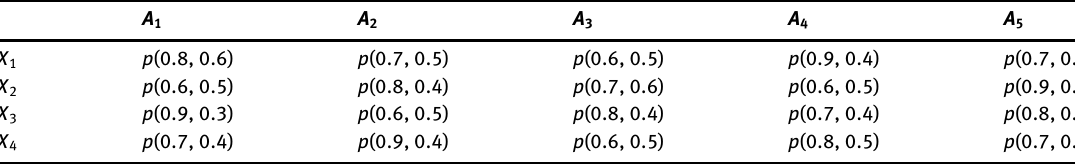
Table 4: Pythagorean Fuzzy Decision by Decision Maker d 1 .